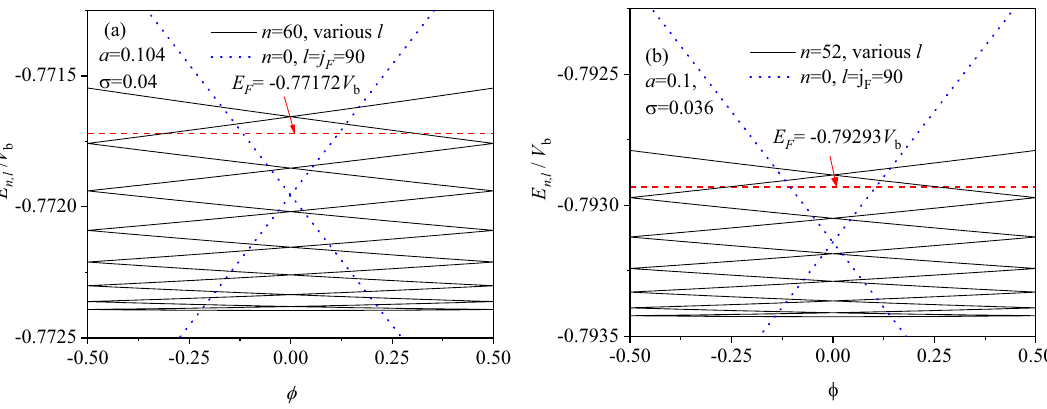
1 / 4 s 2 , where ( a ) n = 60 and ( b ) = +